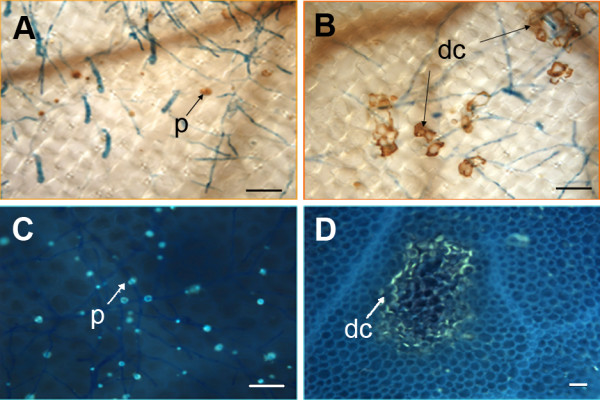
Hydrogen peroxide and callose accumulation in edr2-6. Three-week-old plants were inoculated with G. cichoracearum and stained for either hydrogen peroxide (A, B) or callose (C, D). (A, C) Col-0, (B, D) edr2-6. In D, callose outlines dead mesophyll cells in edr2-6. dc, dead cells; p, papilla. Bar = 22 μm.